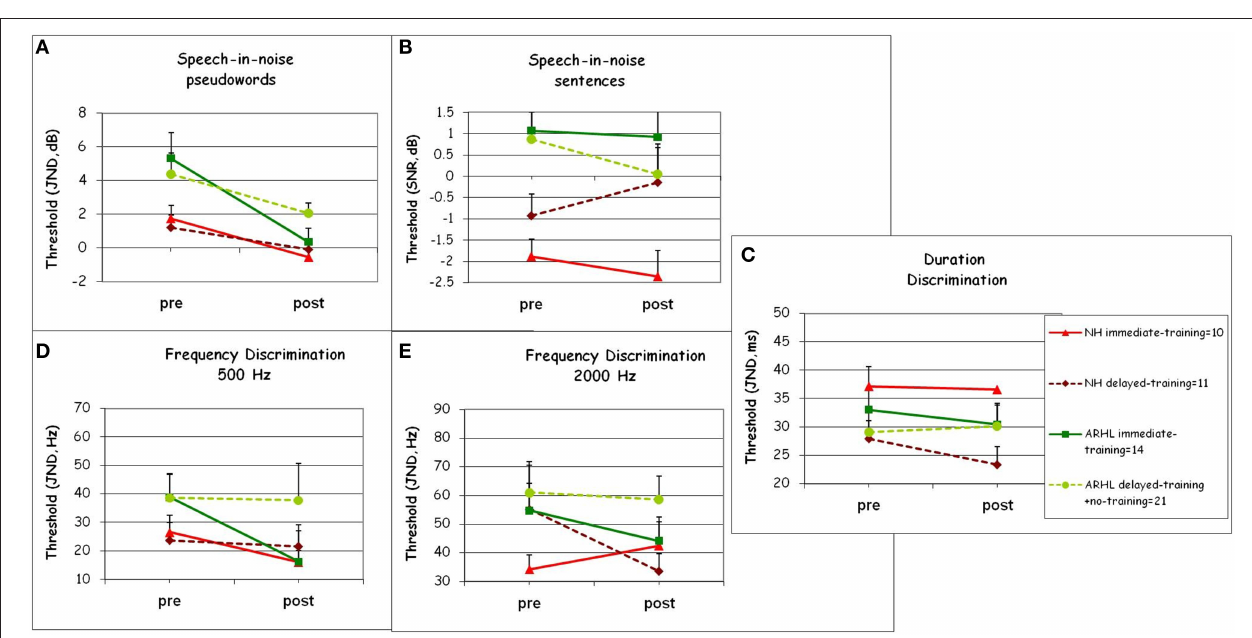
FIGURE 5 | Generalization. Means and SDs of (A) speech-in-noise pseudowords and (B) speech-in-noise sentences thresholds in dBs (C) duration discrimination in milliseconds (ms) (D) 500Hz frequency discrimination and (E) 2000Hz frequency discrimination thresholds inHz, obtained from pre- and post-tests for Normal-Hearing (NH) and Age-Related Hearing Loss (ARHL) groups. For the subgroups: NH immediate-training, ARHL immediate-training, NH delayed-training, and ARHL delayed-training + no-training. See Materials and Methods—Section Generalization for subgroups division.